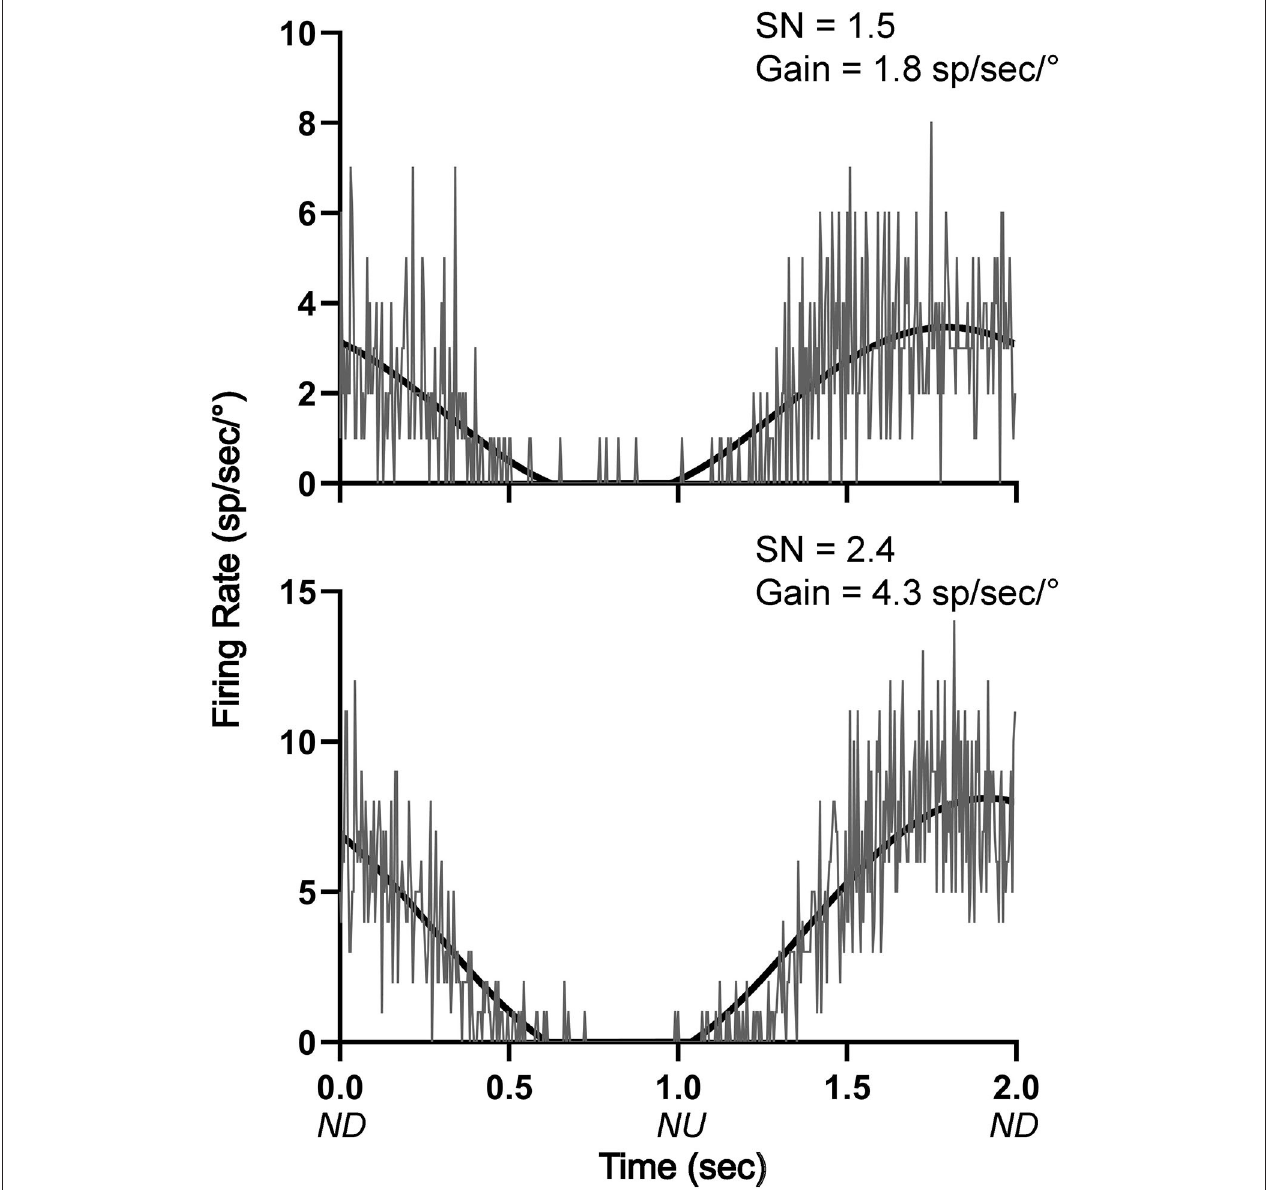
FIGURE 8 | Averaged responses ( ∼ 30 trials) of two LTF units with CRA to 10 ◦ sinusoidal rotations in the pitch plane at 0.5Hz. Bin width was 4ms (500 bins/trace). A sine wave fitted to responses is shown by black lines. The signal-to-noise (SN) ratio and gain for each unit’s response is indicated. ND, nose-down; NU, nose-up.